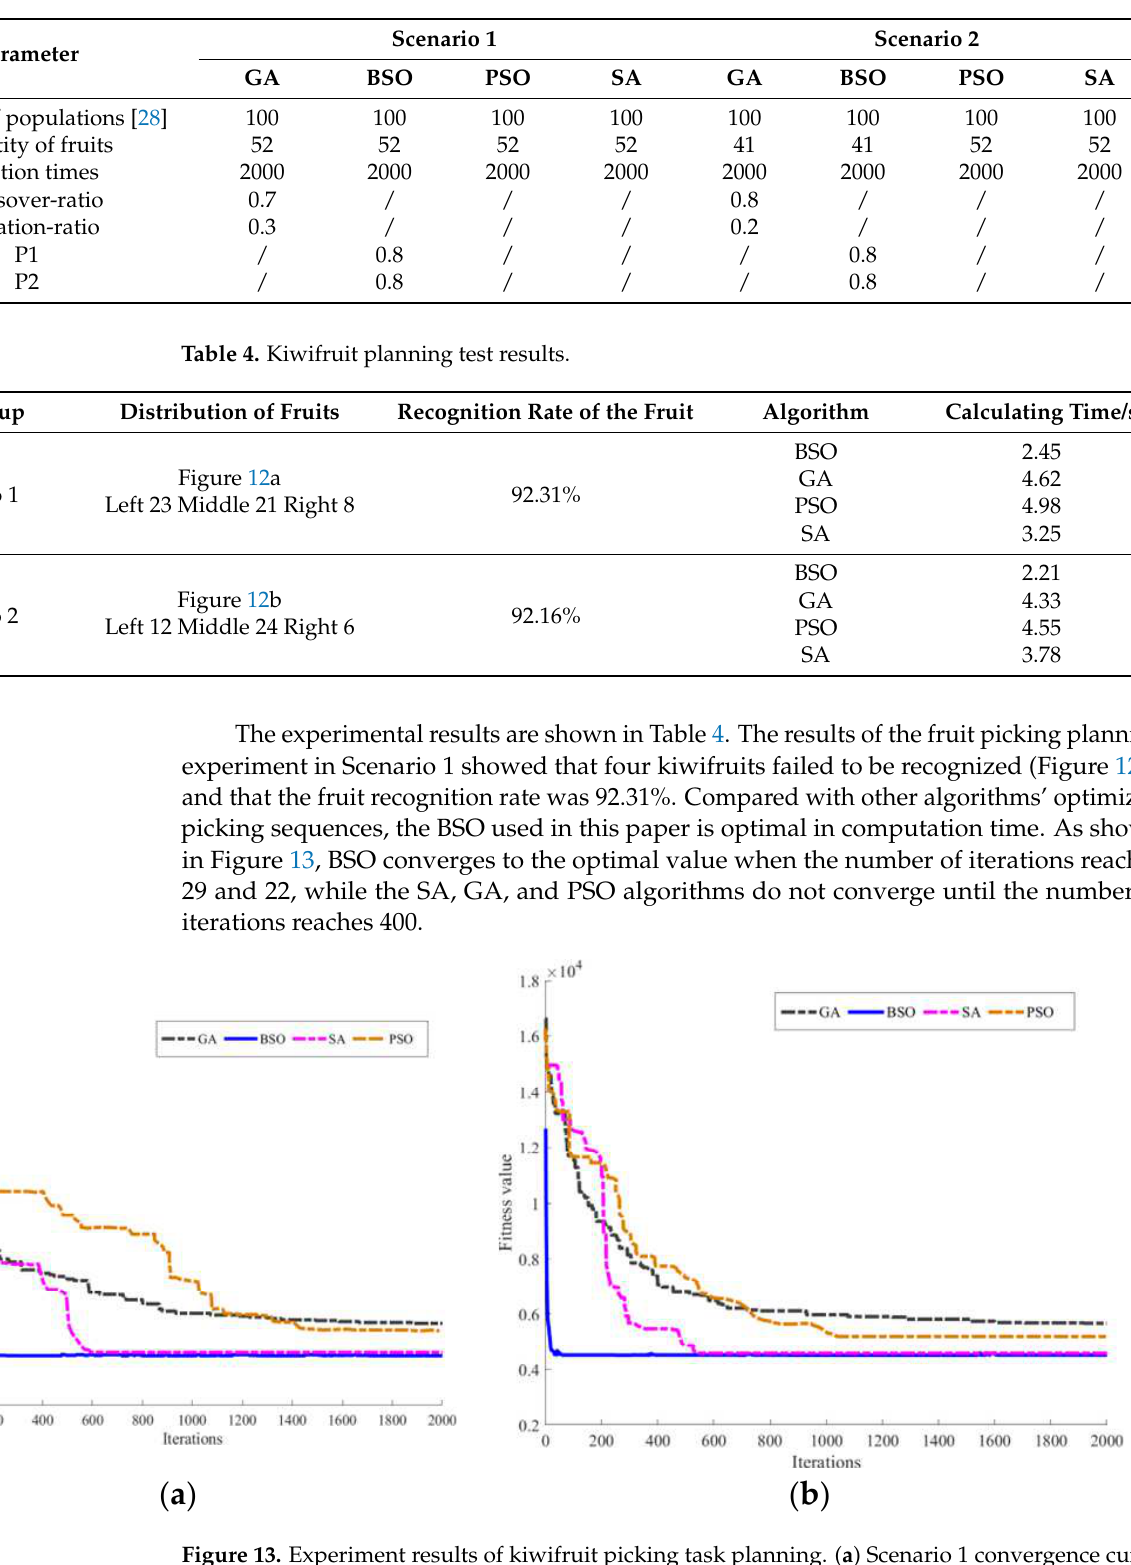
Table 3. Algorithm parameters.